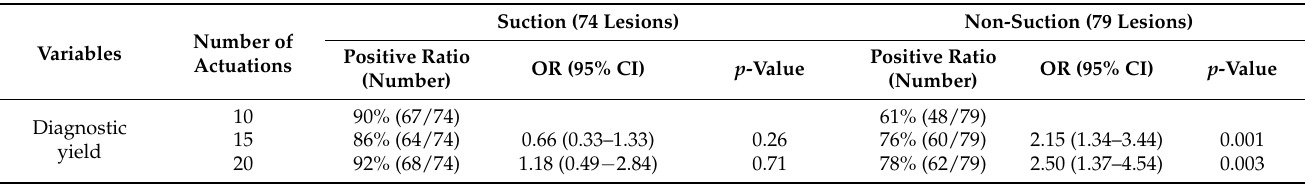
Table 2. Comparison of diagnostic yield according to the number of needle actuations (10/15/20) using suction and non-suction methods in malignant lesions (per lesion, study I).